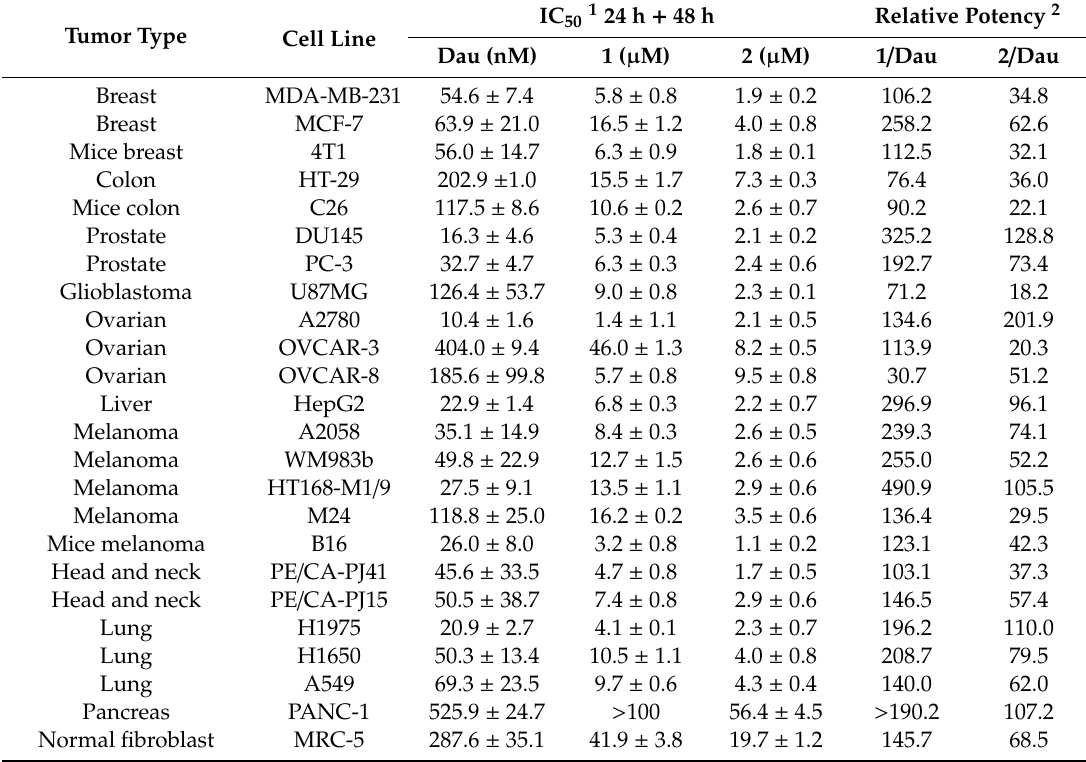
Table 1. Anti-proliferative e ff ect of free drug Dau and GnRH-III-Dau conjugates 1 and 2 on various cell